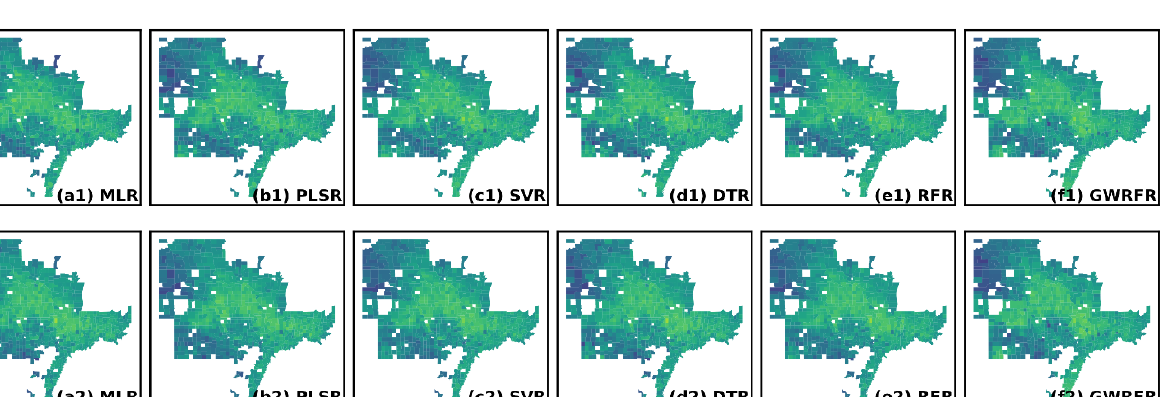
Figure 4. The spatial distribution of predicted yield of ( a ) MLR, ( b ) PLSR, ( c ) SVR, ( d ) DTR, ( e ) RFR, and ( f ) GWRFR using (1) full-length features, (2) vegetation indices derived from RS data, (3) GPP, (4) climate data, and (5) soil data. 3.2.1. Full-Length Features We trained all the six machine learning models with full-length features that include NDVI and EVI, GPP, climate variables (temperature, precipitation, VPD, and mean dew point temperature), and soil data. We present the R 2 and RMSE of all six models in Figure 5. The derived R 2 ranges from 0.791 to 0.901. The R 2 and RMSE of GWRFR are 0.901 and 0.764 MT/ha, respectively. The results also illustrate that GWRFR outperforms other five models by 0.04 – 0.11 in terms of R 2 . DTR has the lowest performance (R 2 = 0.743 and RMSE